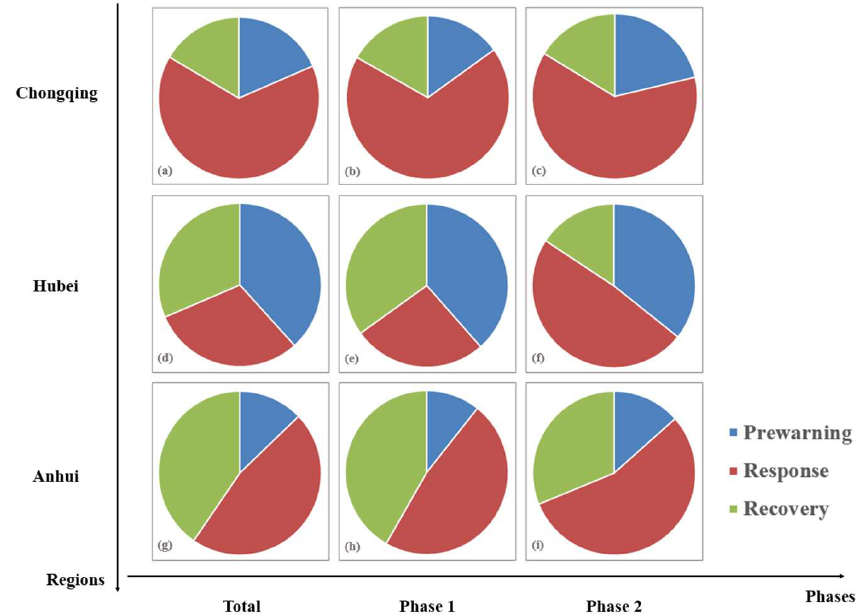
Figure 18. The proportion of different topic statuses in ( a ) all phases of Chongqing, ( b ) phase 1 of Chongqing, ( c ) phase 2 of Chongqing, ( d ) all phases of Hubei, ( e ) phase 1 of Hubei, ( f ) phase 2 of Hubei, ( g ) all phases Anhui, ( h ) phase 1 of Anhui, and ( i ) phase 2 of Anhui.